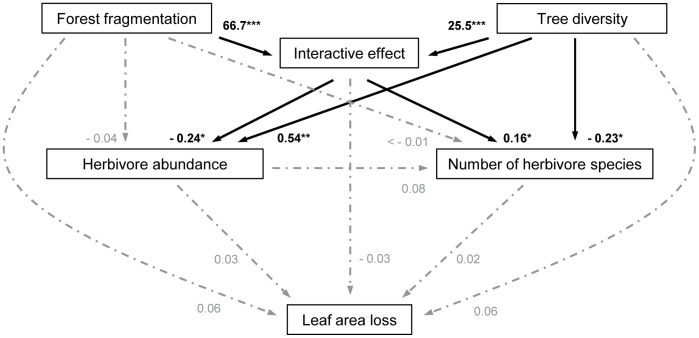
Path model for relationships between forest fragmentation, tree diversity, herbivore community, and leaf area loss.Causal relationships between forest fragmentation, tree diversity, herbivore abundance, number of herbivore species, and leaf area loss. Values next to arrows give effect estimates; black estimates and solid arrows show significant effects, and stars demark the significance level (pMCMC: 0.050< * >0.010< ** >0.001< *** >0.000).